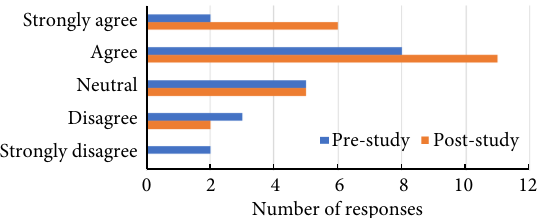
Fig. 8 Participants ’ self-reported capability of surfacing fairness concerns before and after using FID.